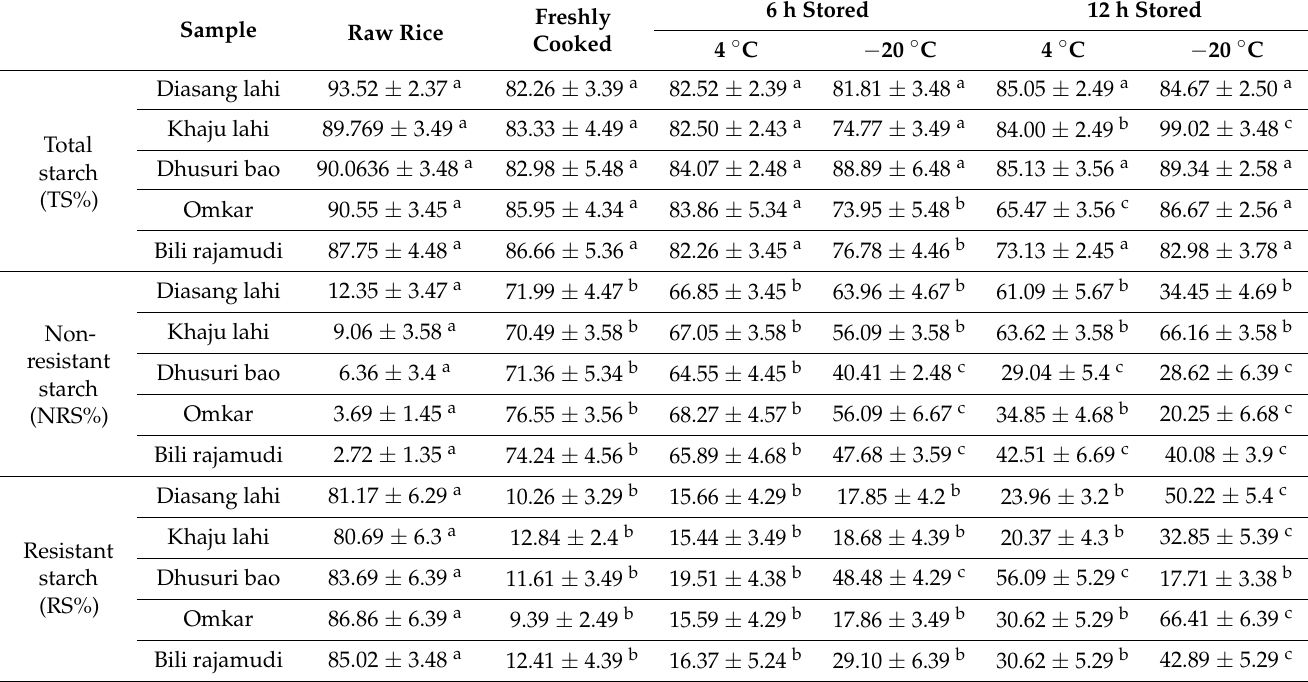
Table 3. Total starch% (TS%), Non-resistant starch% (NRS%), and Resistant starch% (RS%) of rice